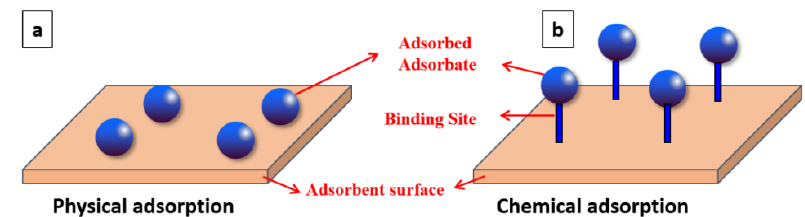
Figure 1. Monolayer ( a ) and multilayer formation ( b ) [11].